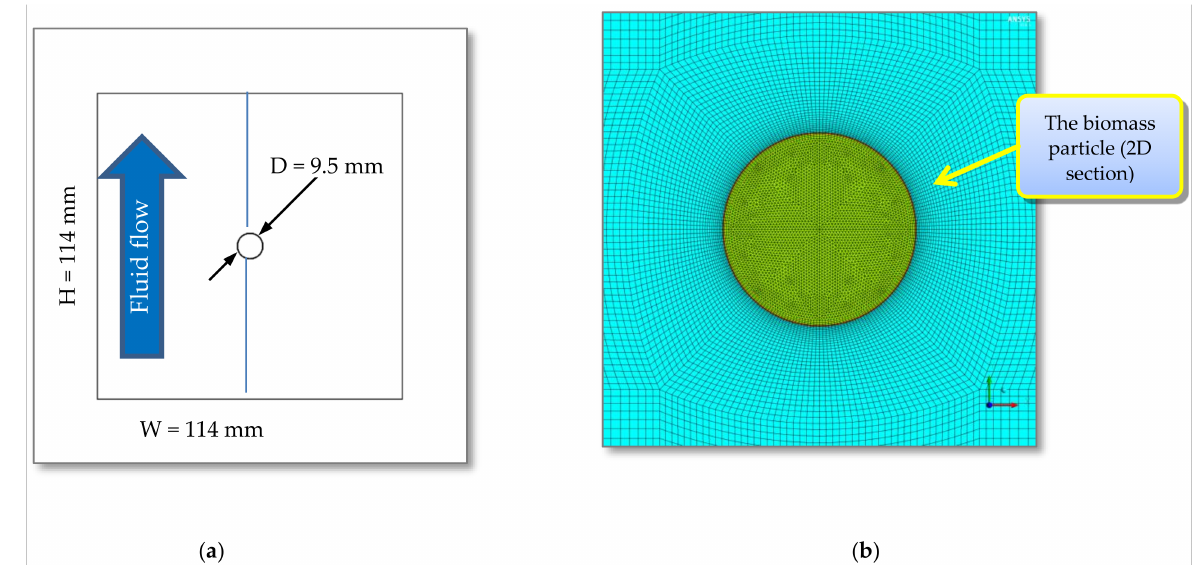
Figure 1. ( a ) Computational domain form and dimensions and ( b ) discretization used in 2D